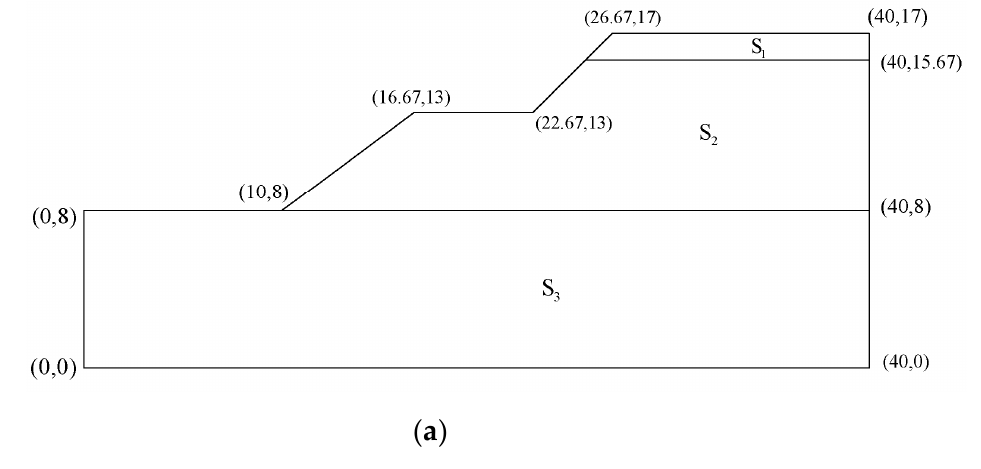
12 Figure 6. Slip-line field of strip footing. 4.2. Slope Stability In this example, the plane strain analysis of a slope subjected to self-weight is carried out. To assess the safety of the slope shown in Figure 7, the strength reduction method is